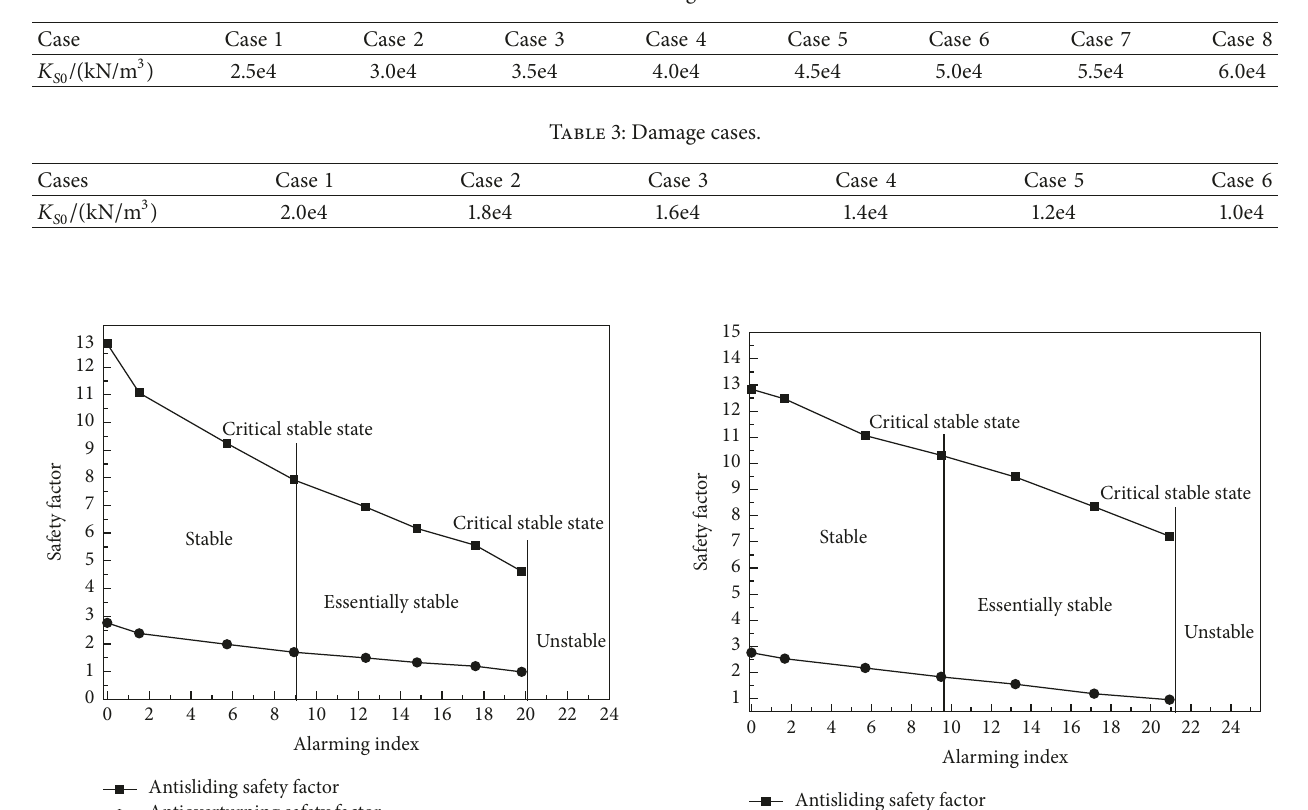
Table 2: Damage cases.